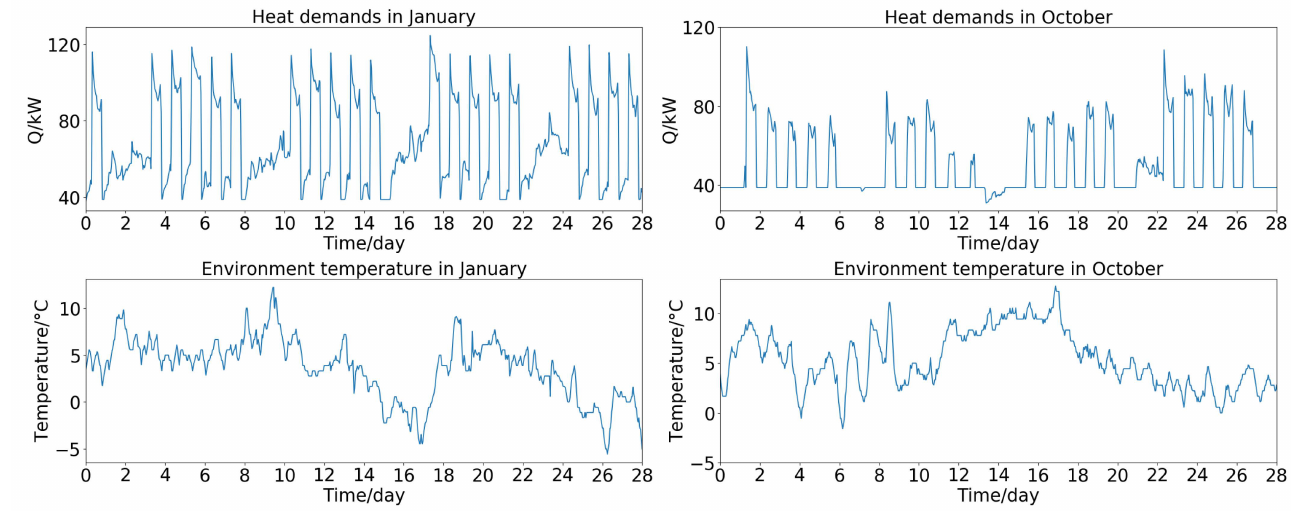
Figure 12. The environment temperature and the heat demand of January and October for the